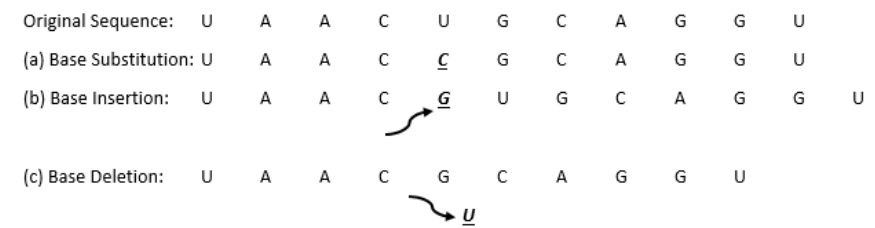
Figure 11. Examples of point mutations in an RNA sequence.